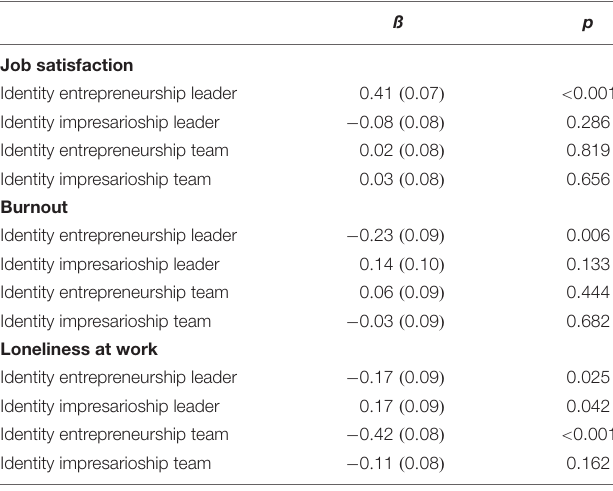
TABLE 3 | Standardized direct effects of identity entrepreneurship and impresarioship (leader/team) on outcomes from structural equation model.